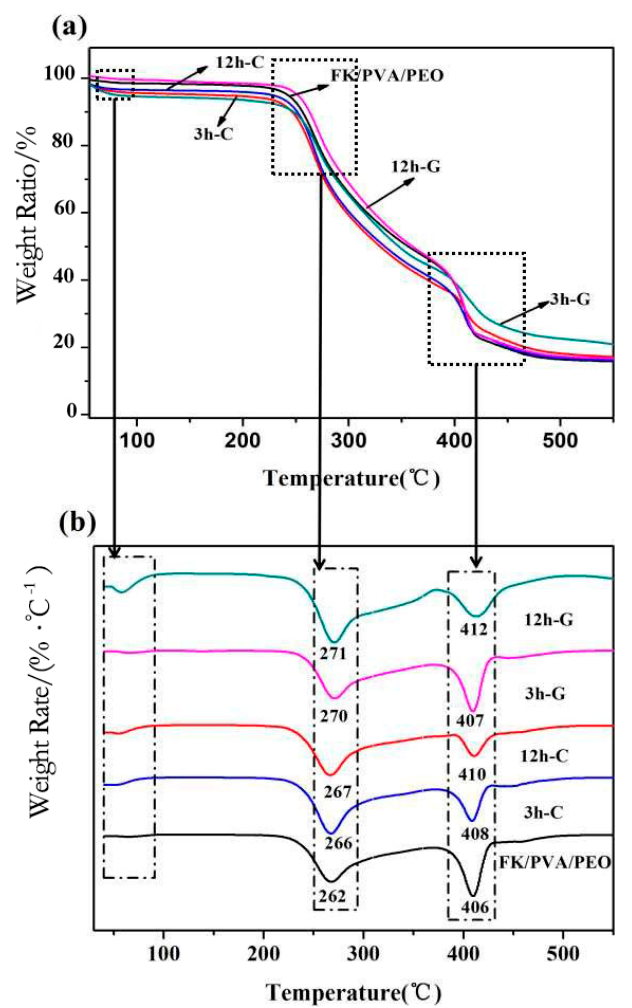
Figure 4. The thermal analysis of as-prepared and crosslinked FK/PVA/PEO nanofiber membranes: ( a ) TGA curves; and ( b ) DTG curves. ( a ) TGA curves; and ( b ) DTG